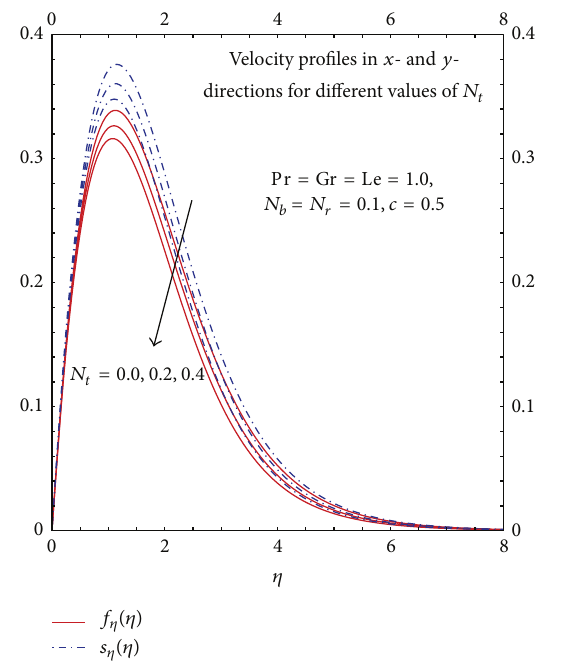
Figure 10: Graphs of 𝑓 𝜂 (𝜂) and 𝑠 𝜂 (𝜂) for different 𝑁 𝑡 .